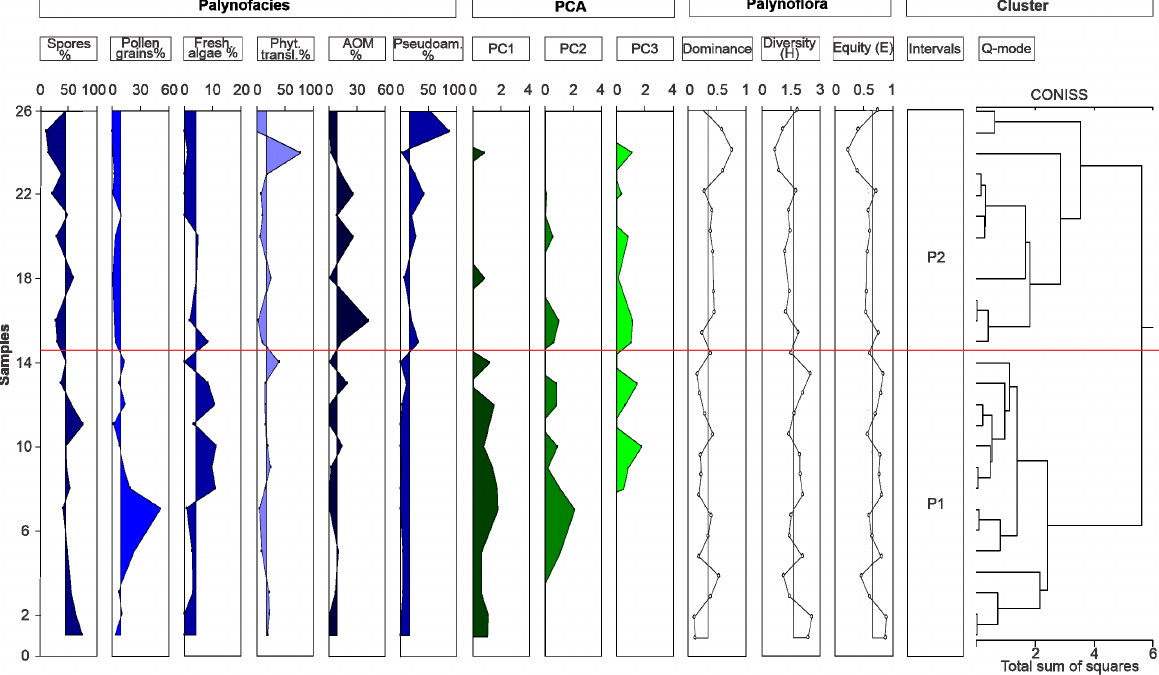
Figure 7. Stratigraphical distribution of palynofacies ratio, Principal Component Analysis (palynofacies) (PCA), palynoflora ecological indexes ratio, and paleoenvironmental intervals (Q-mode